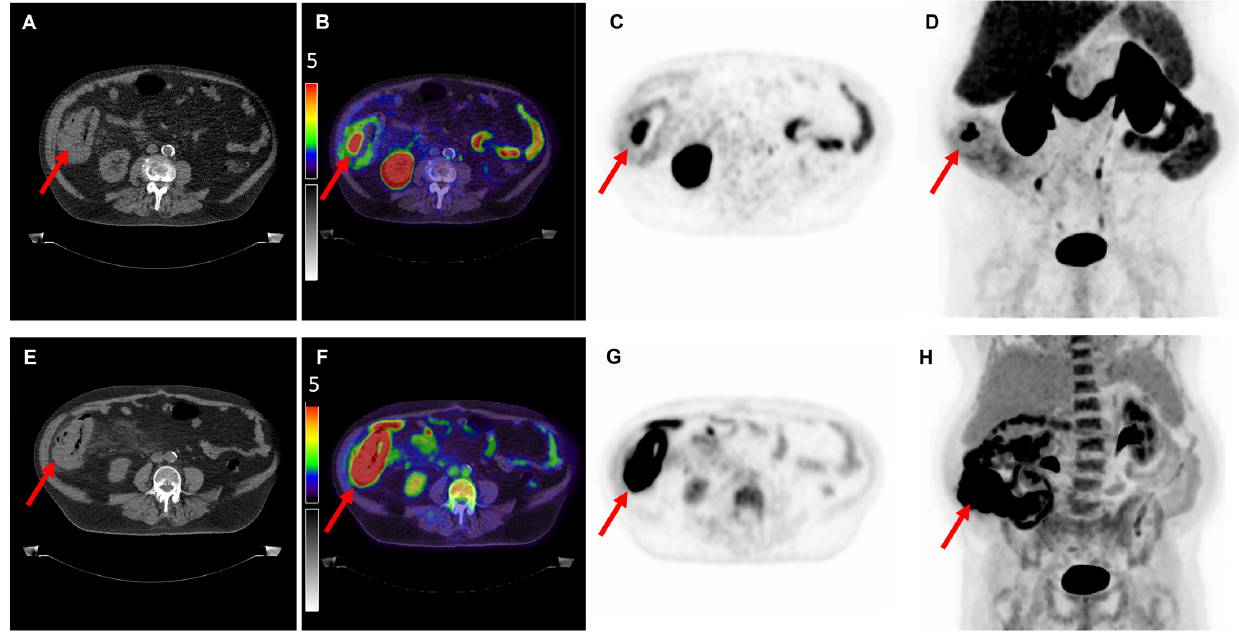
Figure 1. Overview of imaging modalities of a patient with pT3N0M0 colon carcinoma (patient 1). The arrows indicate ( upper row ) a lesion with intense [ 18 F]DCFPyL expression with an SUV max of 9.9 and ( bottom row ) a lesion with [ 18 F]FDG uptake with an SUV max of 45.5. From left to right: low-dose CT ( A , E ), fused PET/CT ( B , F ), PET ( C , G ), and the maximal intensity projection (MIP, ( D , H )). Image scale SUV 0 ‐ 5.